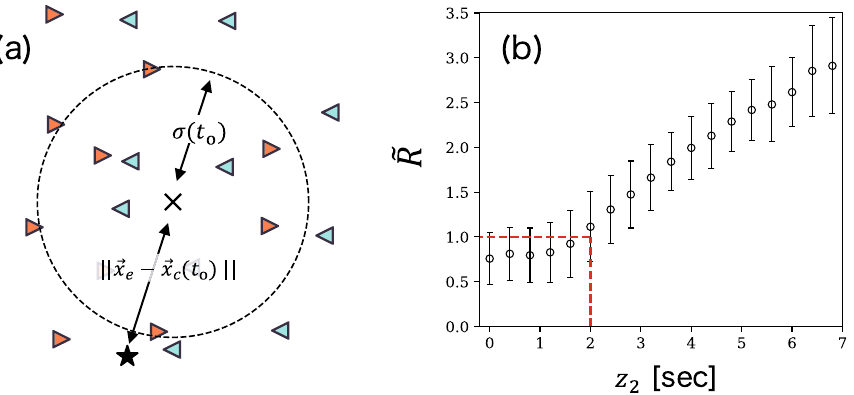
x x c ( t e , o ) and (cid:31) (cid:31) x t z x , t ) 2 e , o ) . 2 ( (cid:31) � ≃